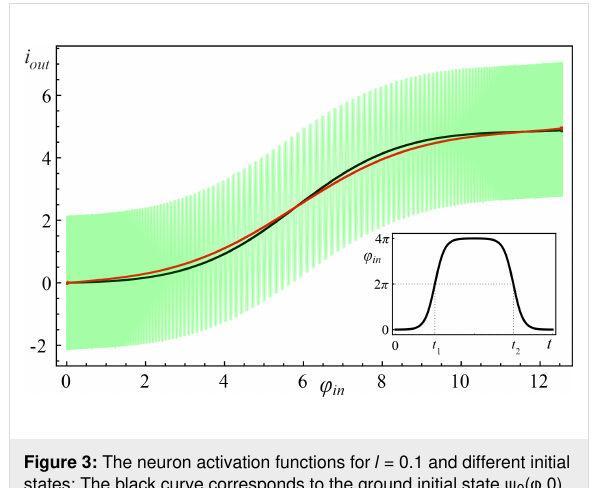
Figure 3: The neuron activation functions for l = 0.1 and different initial states: The black curve corresponds to the ground initial state ψ 0 ( φ ,0), the red curve to the first excited state ψ 1 ( φ ,0), and green curve corre- sponds to the superposition of states ( . Param- eters of the input magnetic flux are D = 0.008, A = 4 π , and t 1 =